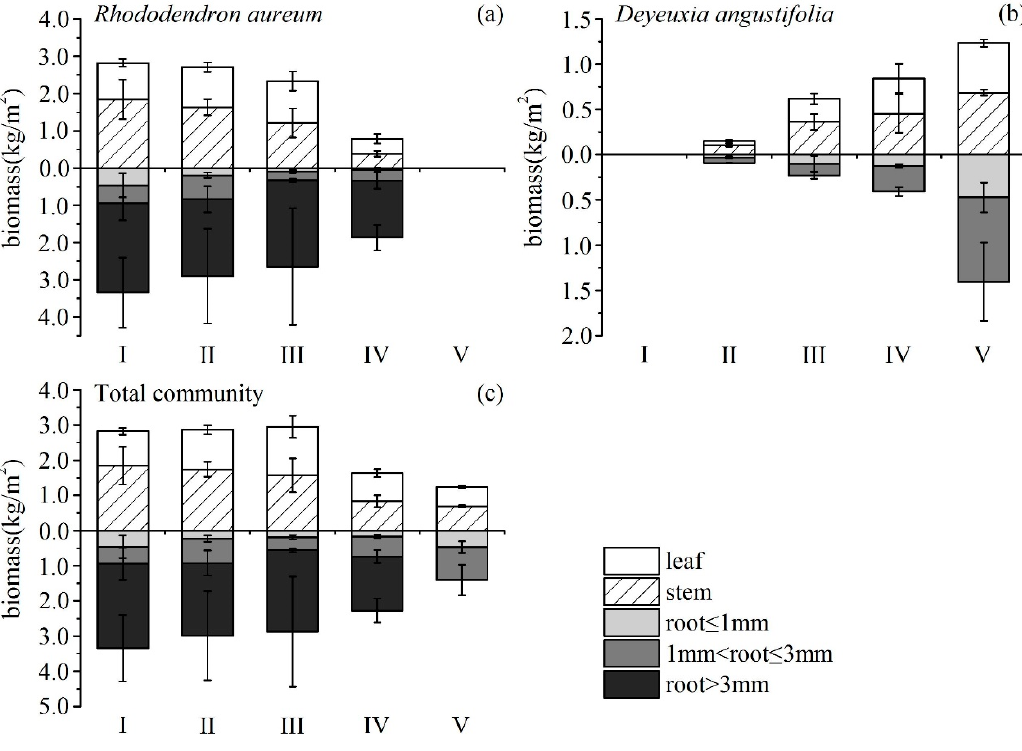
Figure 5. Biomass of different parts of Rhododendron aureum ( a ), Deyeuxia angustifolia ( b ), and the whole community ( c ), under five encroachment levels. Table 4. Biomass allocation to different parts of R. aureum (RA) and D. angustifolia (DA) in plant communities under five encroachment